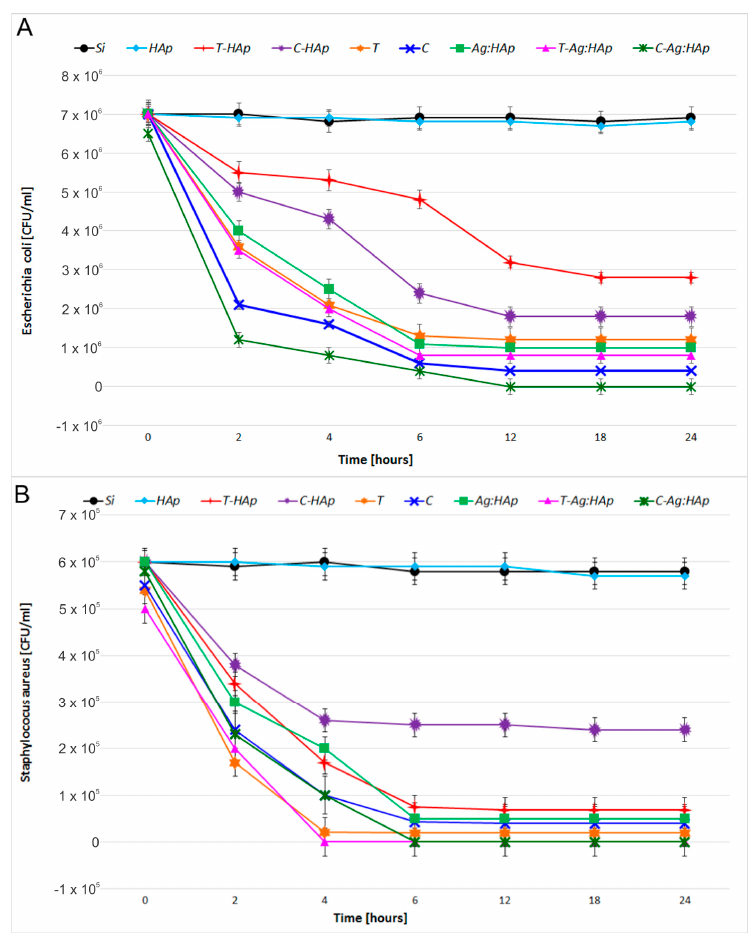
Figure 12. Bactericidal effects of time of contact with the surface of HAp, T-HAp, C-HAp, Ag:HAp, T-Ag:HAp, C-Ag:HAp, C and T thin films for E. coli ATCC 25922 ( A ) and S. aureus 0364 ( B ).